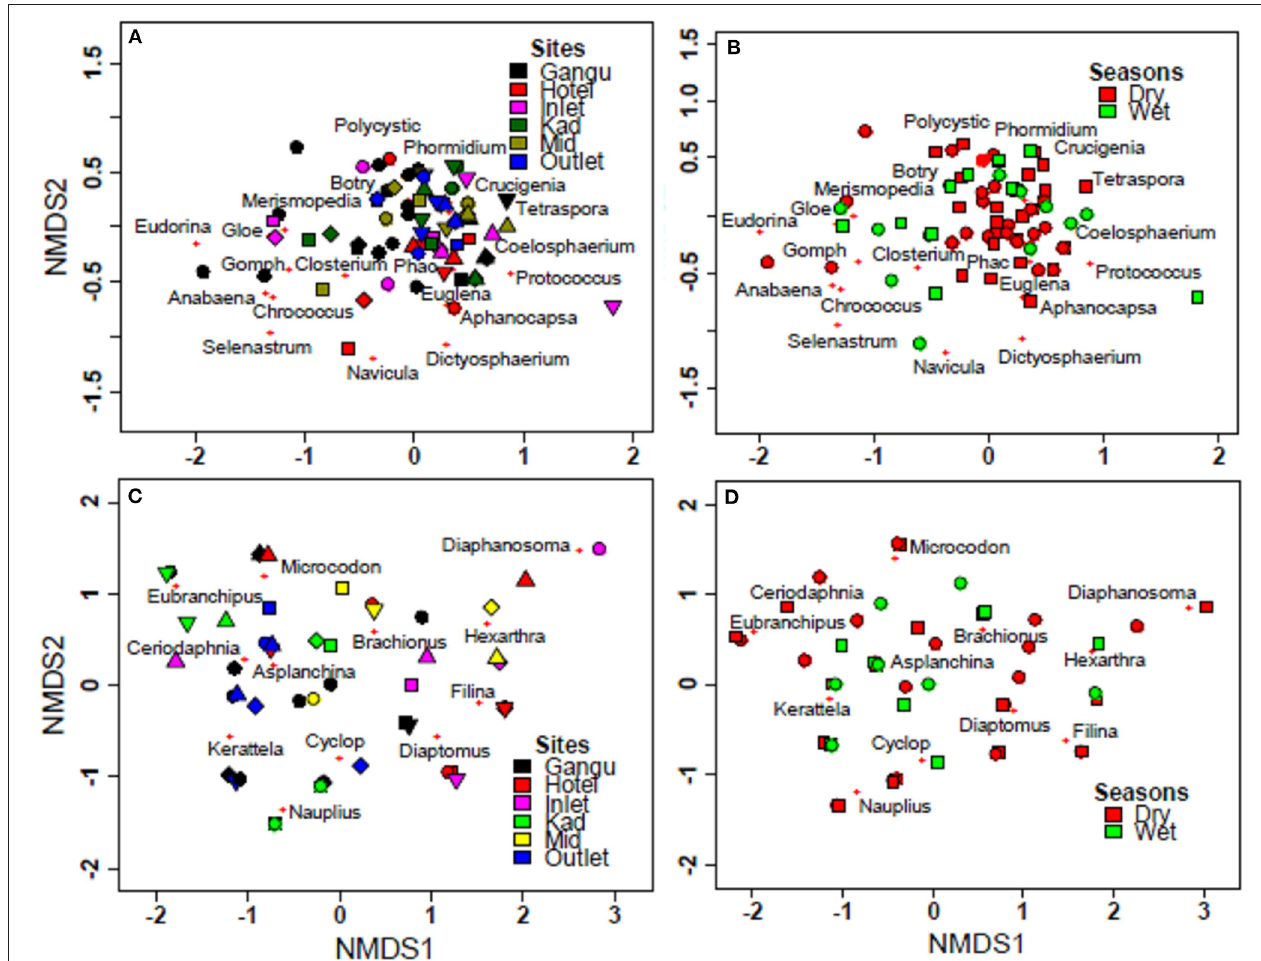
FIGURE 5 | NMDS comparison of phytoplankton and zooplankton in Lake Kanyaboli from February 2020 to February 2021. (A) phytoplankton site comparisons, (B) phytoplankton seasonal comparisons, (C) zooplankton site comparisons (D) zooplankton seasonal comparisons. KAD, Kadenge; MID, Open